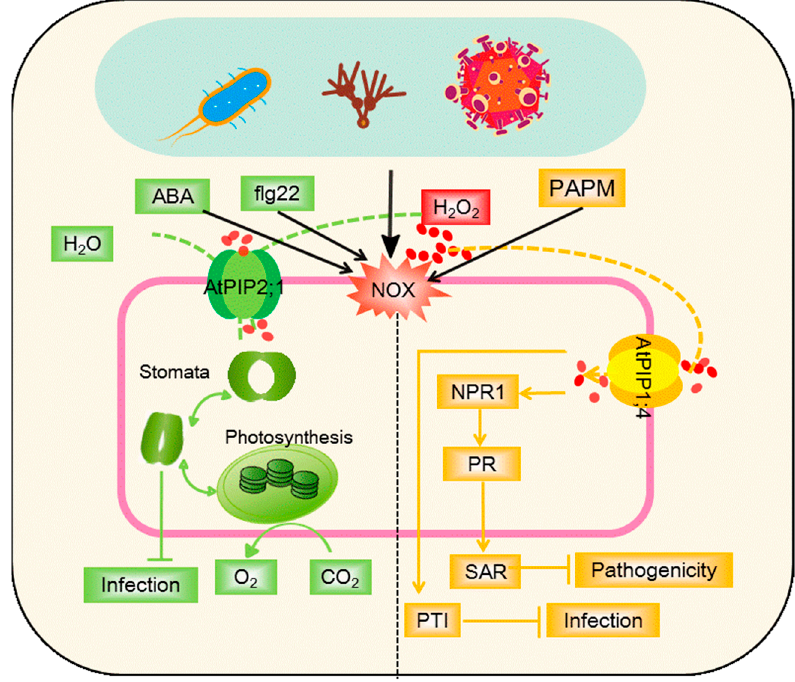
Figure 3. Model of AQPs-mediated linkage of apoplastic H 2 O 2 to stomatal closure (green) and immunity pathways (systemic acquired resistance (SAR) and PAMP-triggered immunity (PTI)) (yellow). Apoplastic H 2 O 2 can be induced by the pathogen or pathogen-associated molecular pattern (PAMPs, flg22), generated through the NADPH oxidase (NOX) activity and rapidly translocated into the cytoplasm under regulation by AtPIP2;1 or AtPIP1;4. Abscisic acid (ABA) and flg22 (a PAMP) activate AtPIP2;1 to facilitate transport of both water and H 2 O 2 , and promote stomatal closure to restrict bacterial invasion. Translocated H 2 O 2 cooperates with SAR or PTI to repress the pathogenicity. ABA, abscisic acid; H 2 O 2 , hydrogen peroxide; PAMP, pathogen-associated molecular patterns; flg22, a 22-amino acid eubacterial flagellin-derived peptide; NOX, NADPH oxidase; PR, pathogenesis-related genes; NPR1, non-inducer of PR genes1; SAR, systemic acquired resistance; PTI, PAMP-triggered immunity.